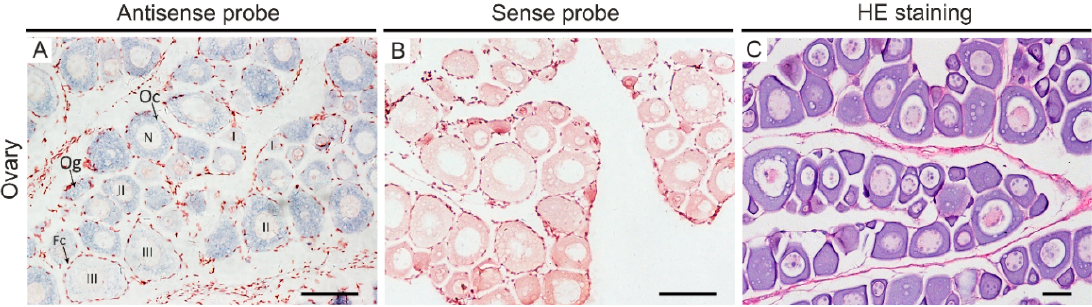
Figure 6. Spatiotemporal expression pattern of Posox3 mRNA in the ovary of adult Japanese flounder. In situ hybridization was performed on paraffin-embedded tissues with a DIG-labeled Posox3 antisense probe ( A ) or a sense probe as a control ( B ). The positive signals are stained with blue, whereas the negative control is not stained. HE staining in the ovary ( C ), counterpart to A. In ovary, the Posox3 mRNA is widely distributed in the cytoplasm of different stages oocytes and highly expressed in stage II oocytes. Fc, follicle cells; N, nucleus; Oc, oocytes; Og, oogonia; I–III, oocyte stages. Scale bar, 100 µm.